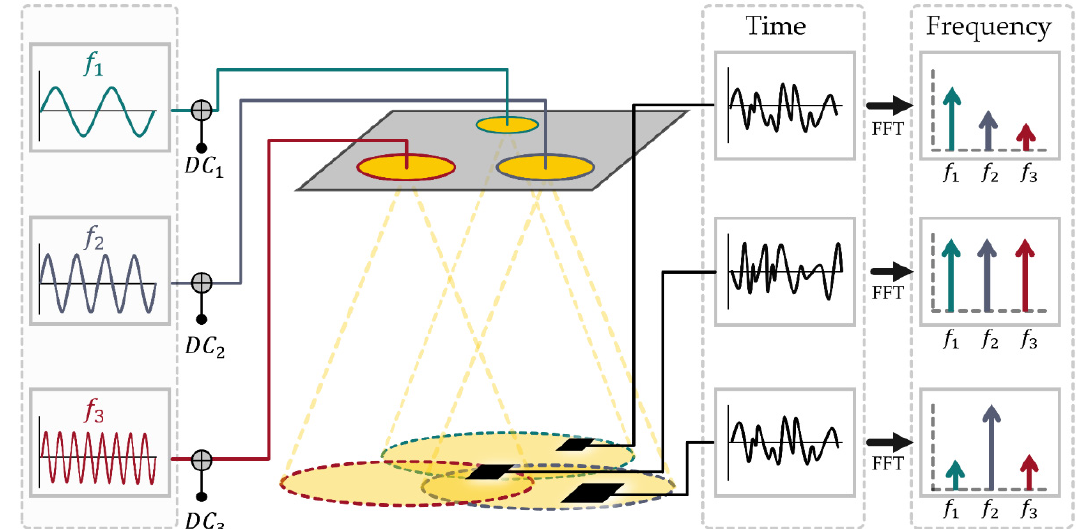
Figure 2. FDM scheme demonstrated for three luminaires. Each luminaire is driven by a DC signal overlaid with a sinusoid of unique frequency. A photodiode detector receives a signal that is the sum of multiple luminaire’s outputs scaled by distance. This signal is then converted to an FFT, and the component at each luminaire’s modulating frequency is used as the RSS.